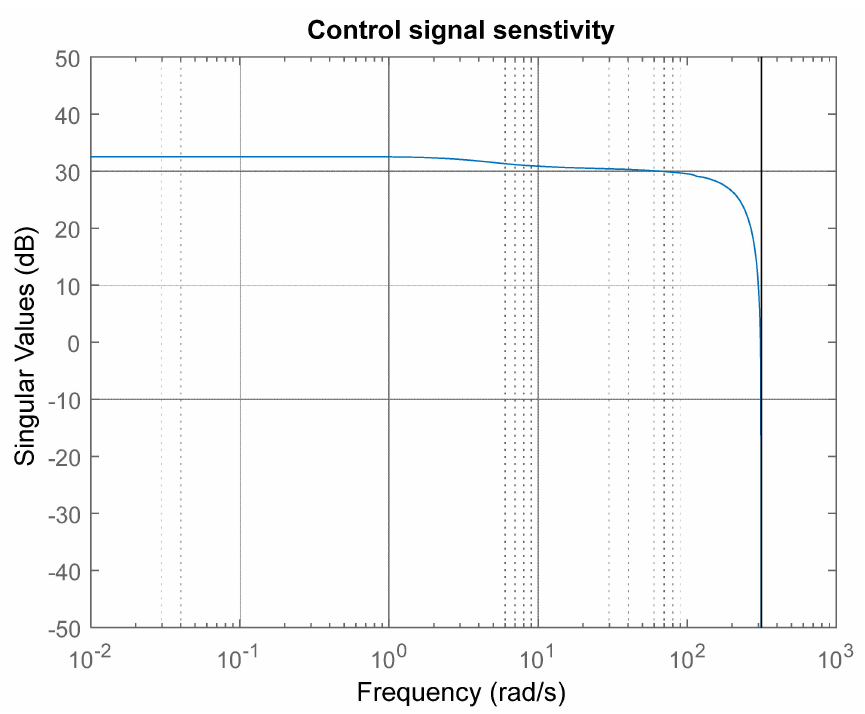
Figure 9. Complementary sensitivity.